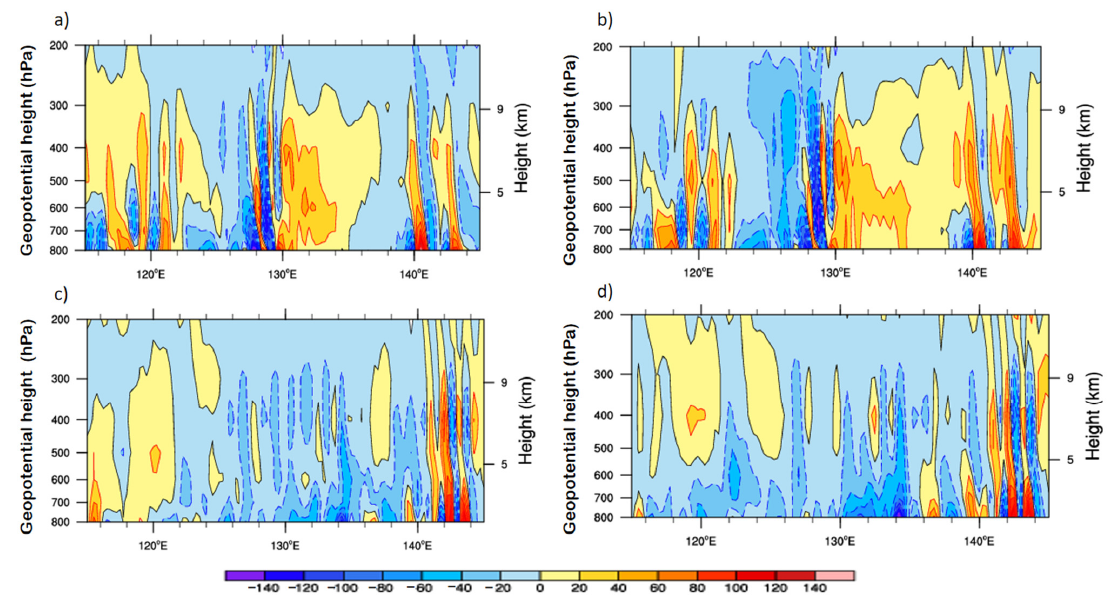
Figure 9. Pressure vertical velocity ( ω ) (10 − 5 Pa s − 1 , shaded) over Northeast China during MCVHR years (2016–2019) and LCVHR years (1979 and 1983–1985): ( a ) MCVHR years at 42° N, ( b ) LCVHR years at 42° N, ( c ) MCVHR years at 50° N, and ( d ) LCVHR years at 50° N. The red (blue) color indicates a positive (negative) significant anomaly. The dashed (solid) lines show ascending (de- scending) motion. Negative (positive) values indicate an upward (downward) motion.